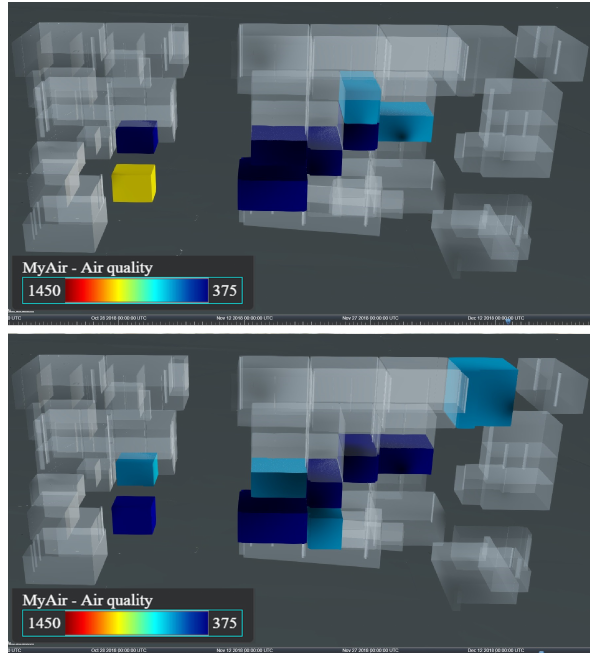
Figure 13. Air quality at two different time slots for several rooms represented as spaces and different colours. For instance, yellow colour means higher concentration, while dark blue shows lower concentration of CO 2